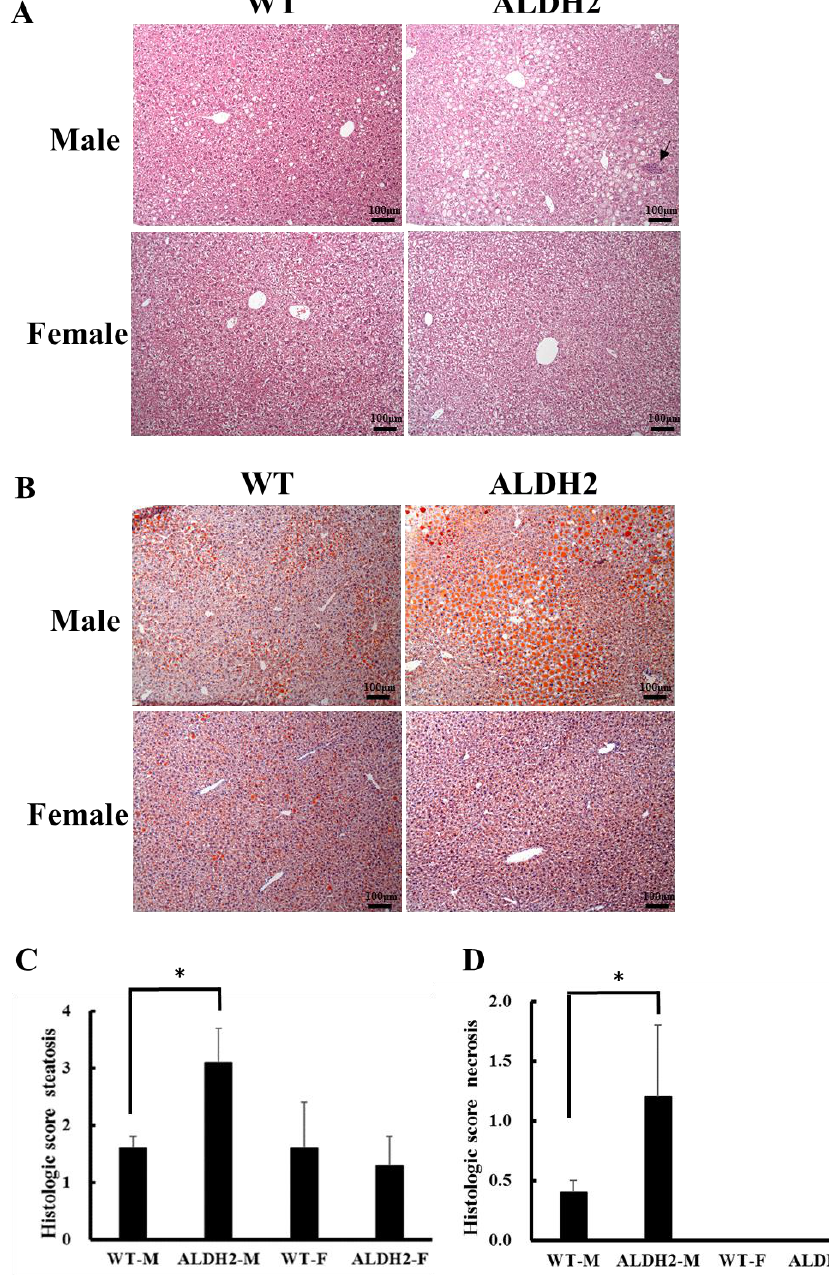
Figure 1. Histologic liver observation, fat drops, steatosis, and necrosis in wild-type and ALDH2 knock-in mice fed HFD. ( A ) H&E staining of liver sections; ( B ) oil red O staining of liver sections; ( C ) steatosis score of liver; ( D ) necrosis score of liver. H&E and oil red O staining (200×). Black arrow is necrosis. * p < 0.05 compared with WT-M.